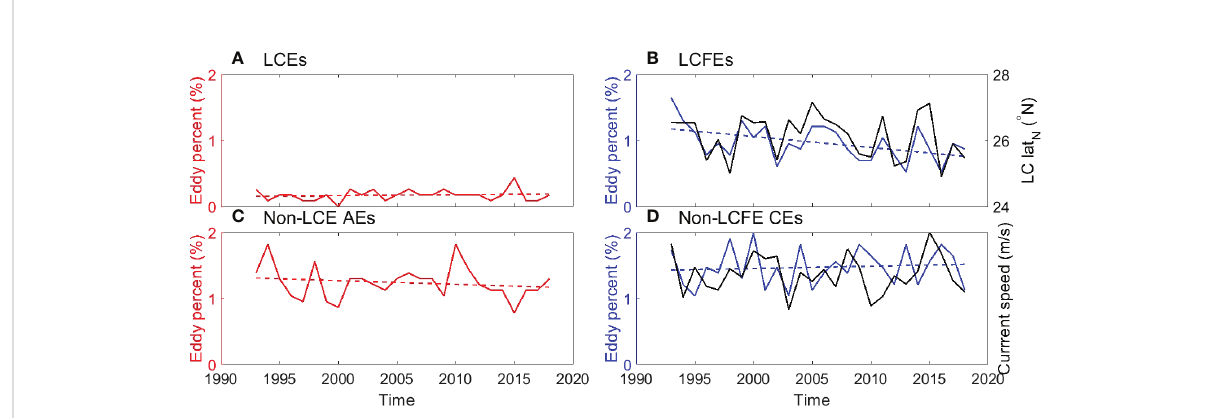
FIGURE 13 Annual number of generated (A) LCEs, (B) LCFEs, (C) non-LCE AEs and (D) non-LCFE CEs and is expressed as percentage of the total new eddy from 1993 to 2018. The black line represents the annual mean northern boundary (°N) of the LC in (B) and the annual mean current speed (m/s) in the western GoM in (D) . The dashed lines represent linear trend of generated